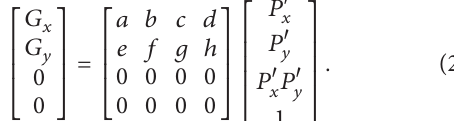
The matrix coefficients 𝑎 – ℎ can be calculated from